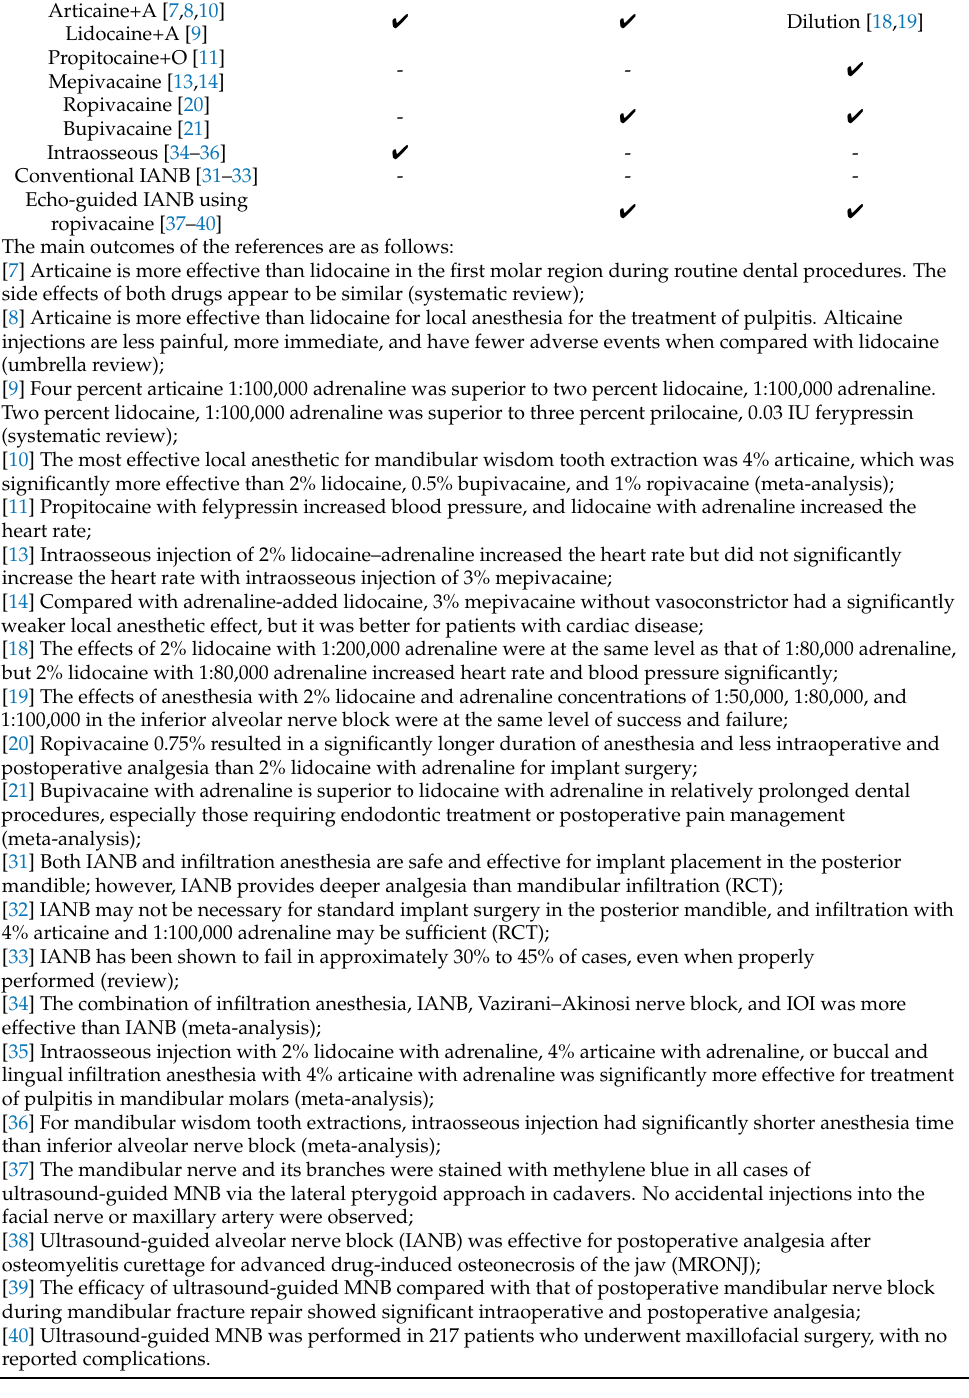
Table 1. Circumstances in which the unique properties and methods of each local anesthetic can be employed. A: adrenaline, O: octapressin, IANB: inferior alveolar nerve block. Wide and Long Cardiovascular Short Duration Duration